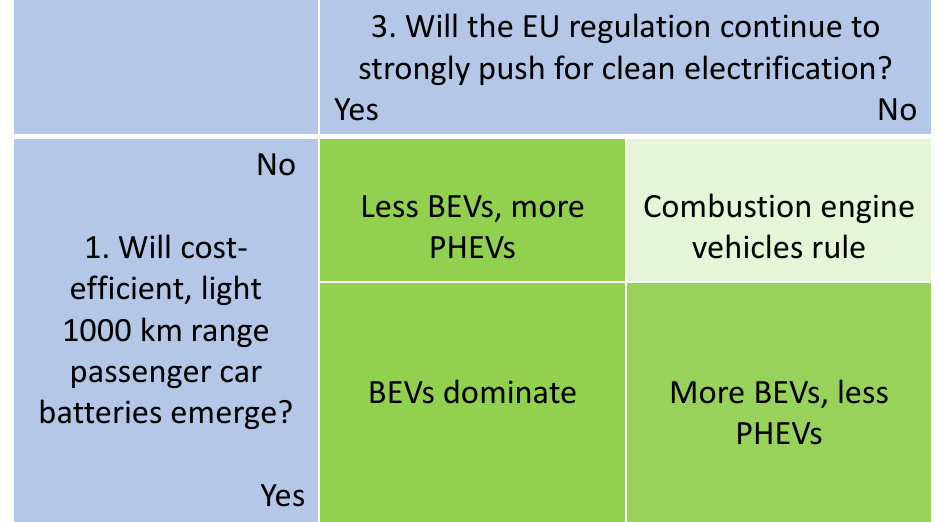
Figure 3. Car fleet view scenarios. BEV = battery electric vehicle (fully electric vehicle) and PHEV = plugin hybrid electric vehicle.